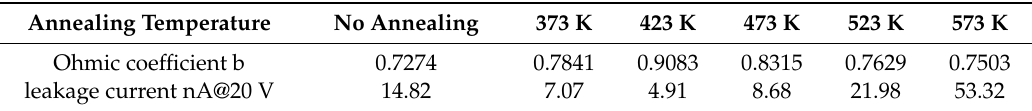
Figure 5. The I–V curves of the Ti-Au/CdZnTe sample after rapid annealing for 4 min at different temperatures. Table 3. The I–V curves fitting results of Ti-Au / CdZnTe after rapid annealing at di ff erent temperatures for 4 Table 3. The I–V curves fitting results of Ti-Au/CdZnTe after rapid annealing at different temperatures for 4 min.